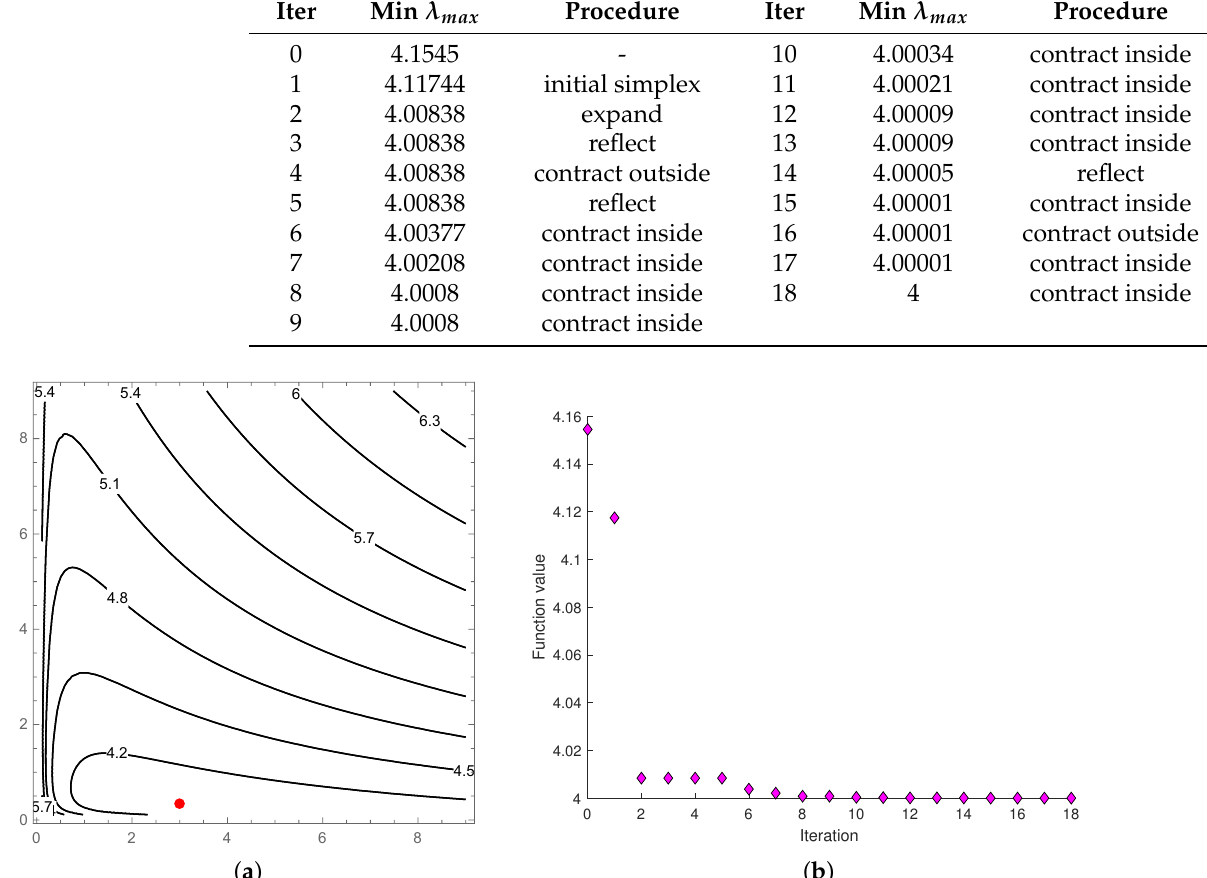
Table 2. Iterationnumber, incumbentoptimalvalueof λ max , andsimplexprocedureforminimization (11).